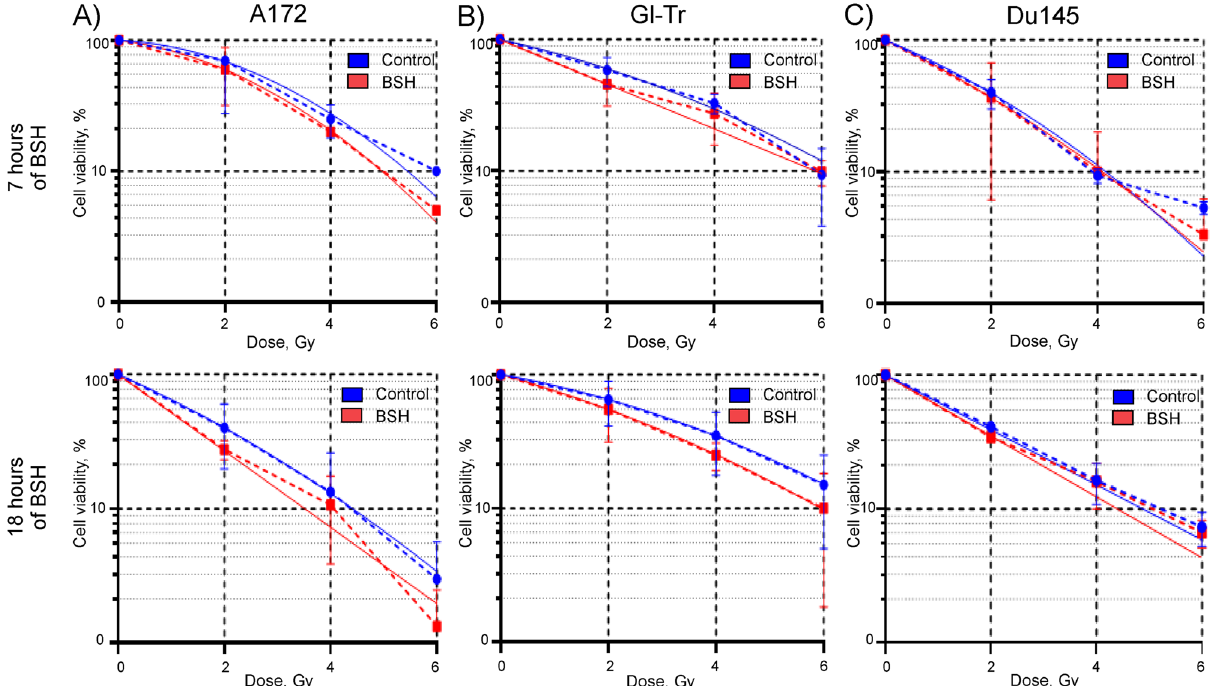
Figure 4. Effect of BSH on cell colony formation after exposure to Bragg peak of 89.7 MeV clinical proton beam. Summary plots for colony assays: ( A ) A172 cells, ( B ) Gl-Tr cells, ( C ) Du145 cells (dashed lines). Data were fitted with a linear-quadratic function of the radiation dose (solid lines) with the parameter β constrained to non-negative values. The cells were incubated in a medium containing 80 ppm of boron for 7 h (up panels) or 18 h (bottom panels) and then irradiated by 89.7 MeV clinical proton beam in a dose range of 0–6 Gy. After treatment, 10 3 cells were seeded out to form sufficiently large clones consisting of 50 or more cells. Colony formation assay was performed in 10–14 days. Each plot summarizes the results of three independent experiments.